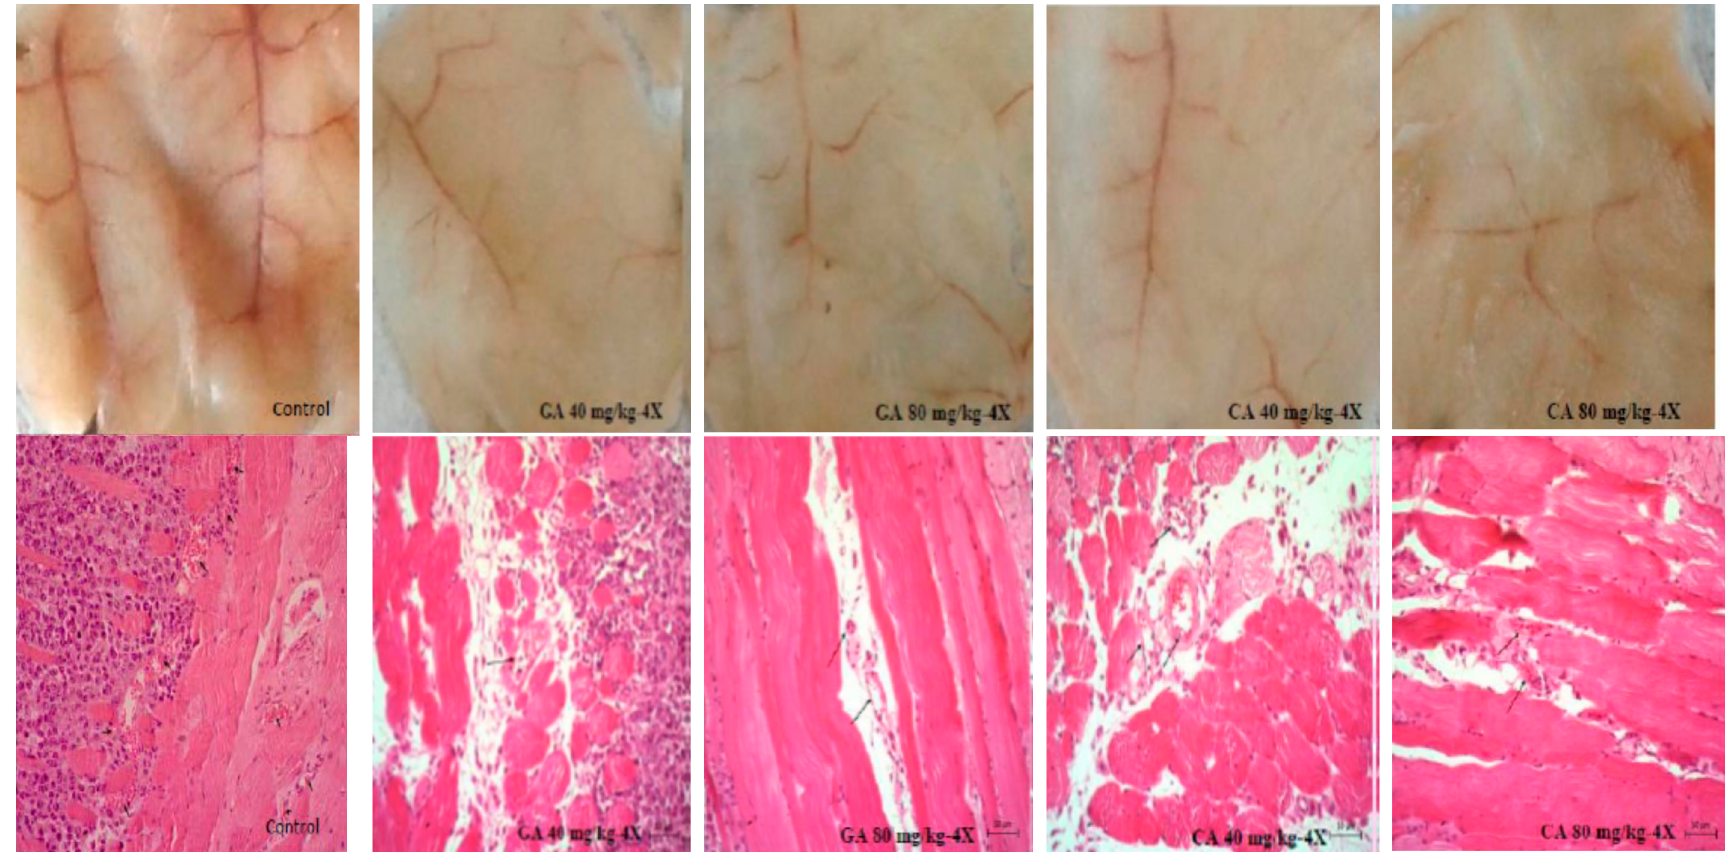
Figure 3. Effect of GA and CA on the suppression of angiogenesis in vivo . Inhibition of angiogenesis in GA or CA-treated mice is evident (above). Bouin-fixed, paraffin-embedded peritoneum of the control as well as the GA or CA-treated mice were sectioned (7 μ m) and stained with hematoxylin and eosin (HE) dye and observed for microvessel density (MVD) at 200× magnification with a phase-contrast microscope. Decreased MVD in the peritonea of GA- or CA-treated mice is evident (below). Abbreviations: EAT, Ehrlich ascites tumor; GA, gallic acid; CA, caffeic acid.